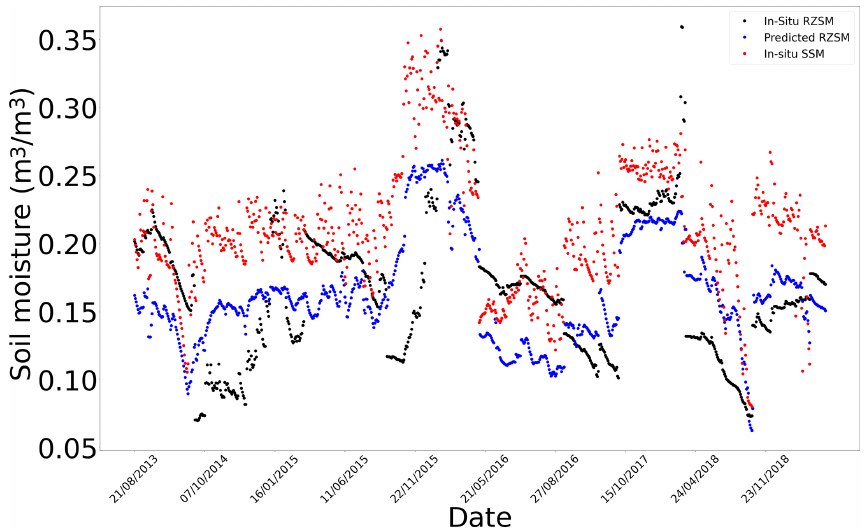
Figure E12. In situ SSM, in situ RZSM, and predicted RZSM series at station 2.04 (HOBE) with model ANN_SSM_ NDVI_EVAP-EFF-